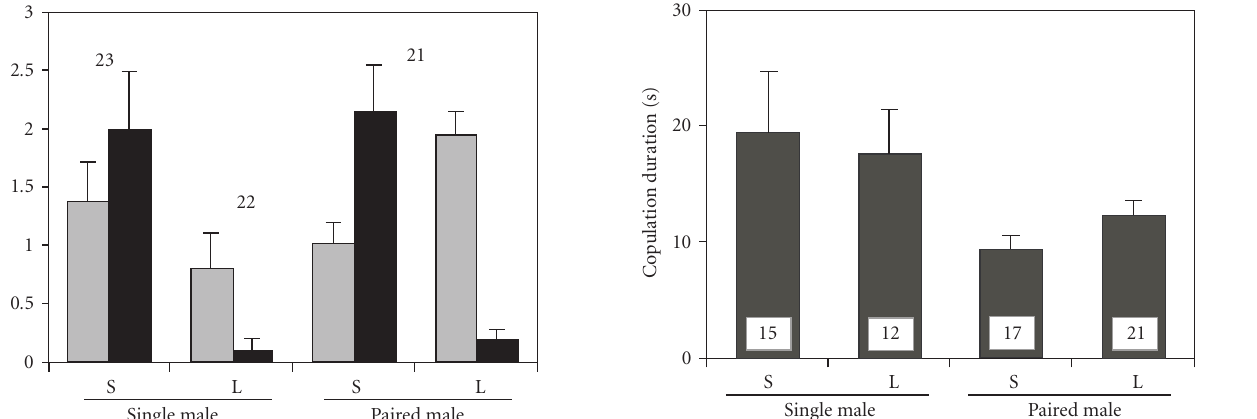
The females displayed two rejection behaviors: